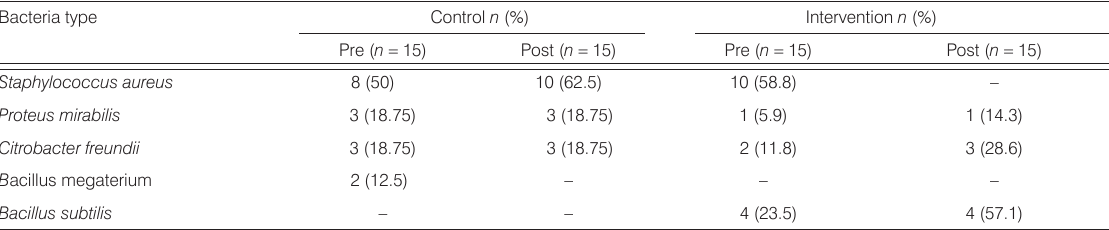
Table 4. Posttest bacteria count differences.